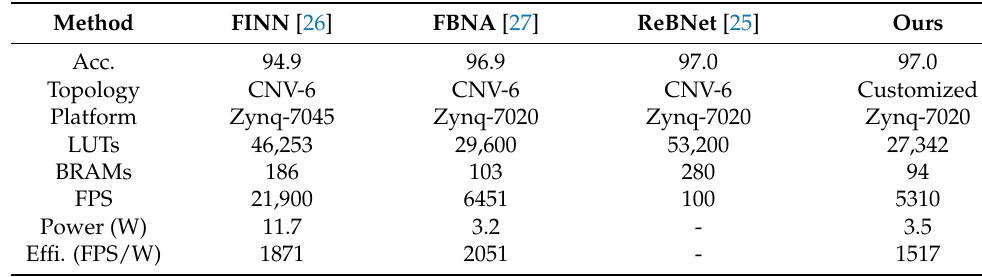
Table 3. Deployment performance of BNNs on SVHN